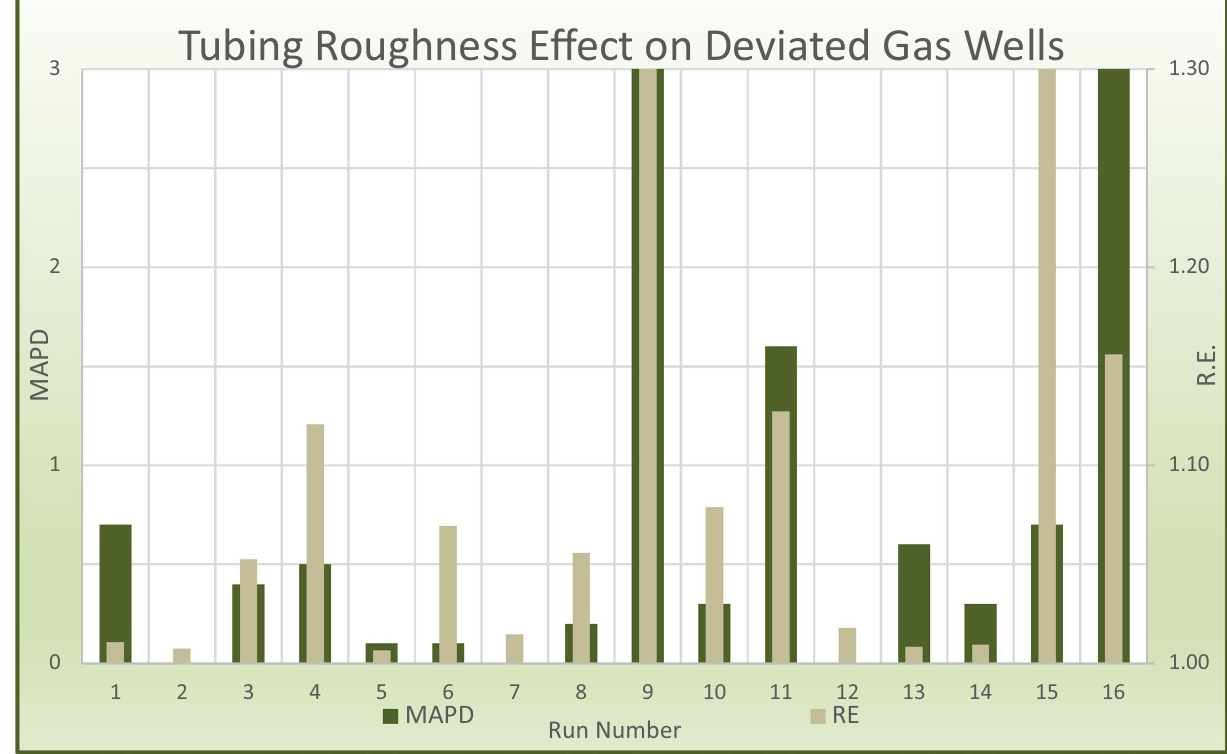
Fig. 10 Effect of tubing roughness on deviated wells using MAPD and RE